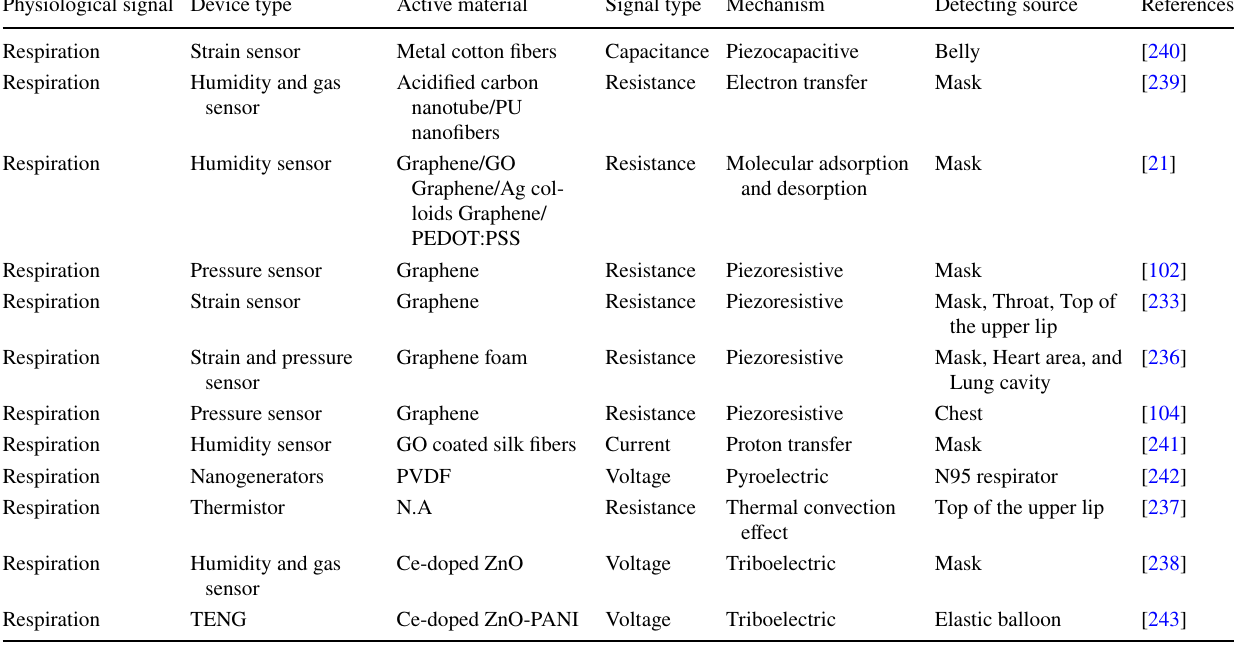
Table 2 Typical respiration pulse sensor Physiological signal Device type Active